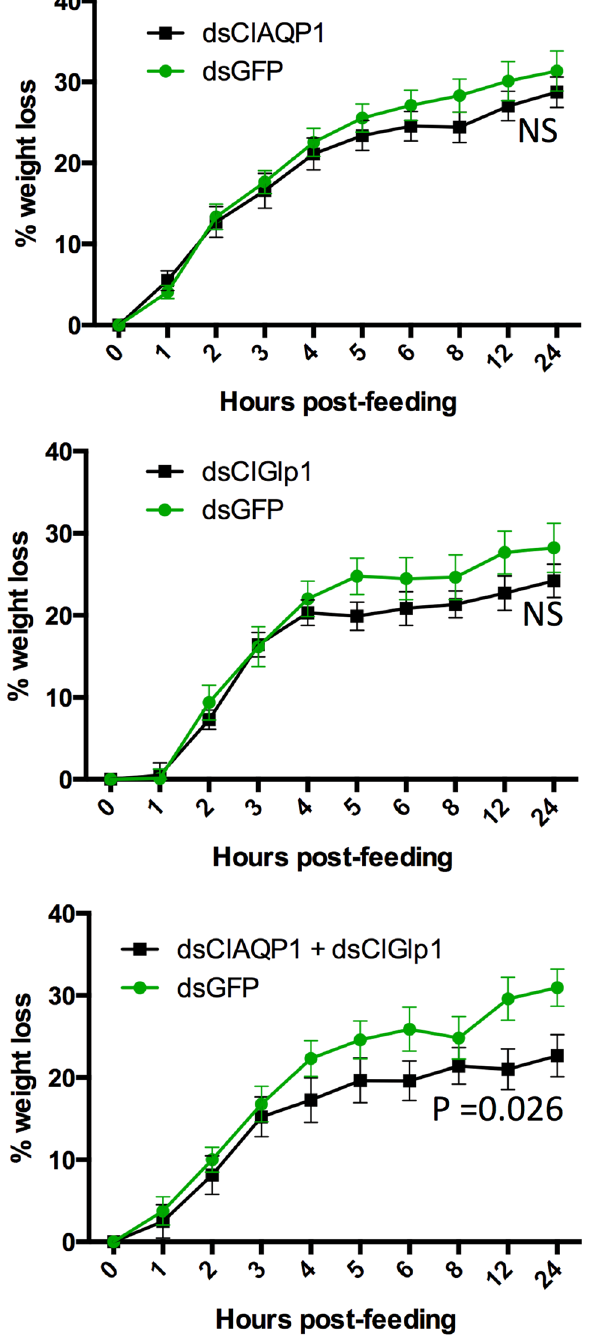
Figure 6. Effect of RNAi on bug excretion after a bloodmeal, as measured by weight loss. All controls were injected with dsRNA against GFP. ( A ) RNAi of ClAQP1. ( B ) RNAi of ClGlp1. ( C ) Double knockdown of ClAQP1 and ClGlp1. The graph shows mean ±